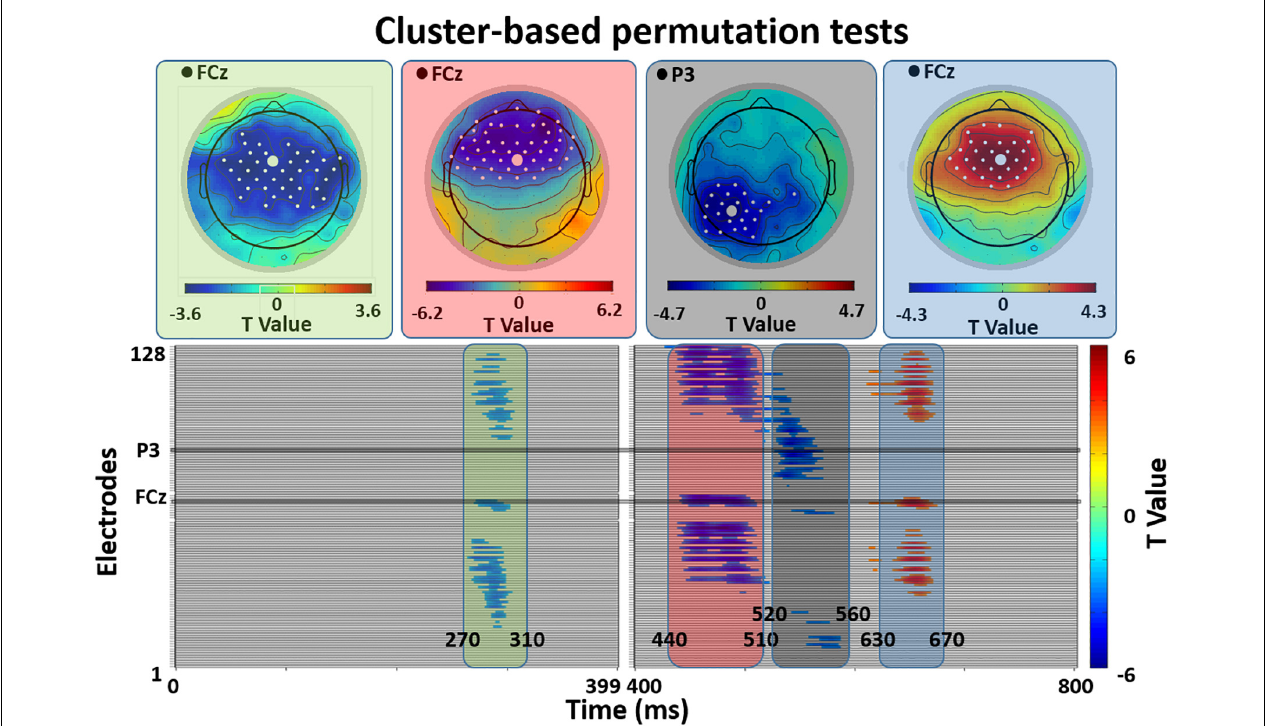
FIGURE 2 | Cluster-based permutation tests of ERP differences between Semantically Related and Unrelated distractor conditions. The lower panels plot significance of ERP differences for all 128 electrodes in four different time-windows post stimulus onset (270–310 ms, 440–510 ms, 520–560 ms, 630–670 ms). The upper panels show the scalp distribution of these effects (related vs. unrelated distractors). White dots indicate electrodes with significant differences. Large white dots indicate the illustrative electrodes in Figure 3